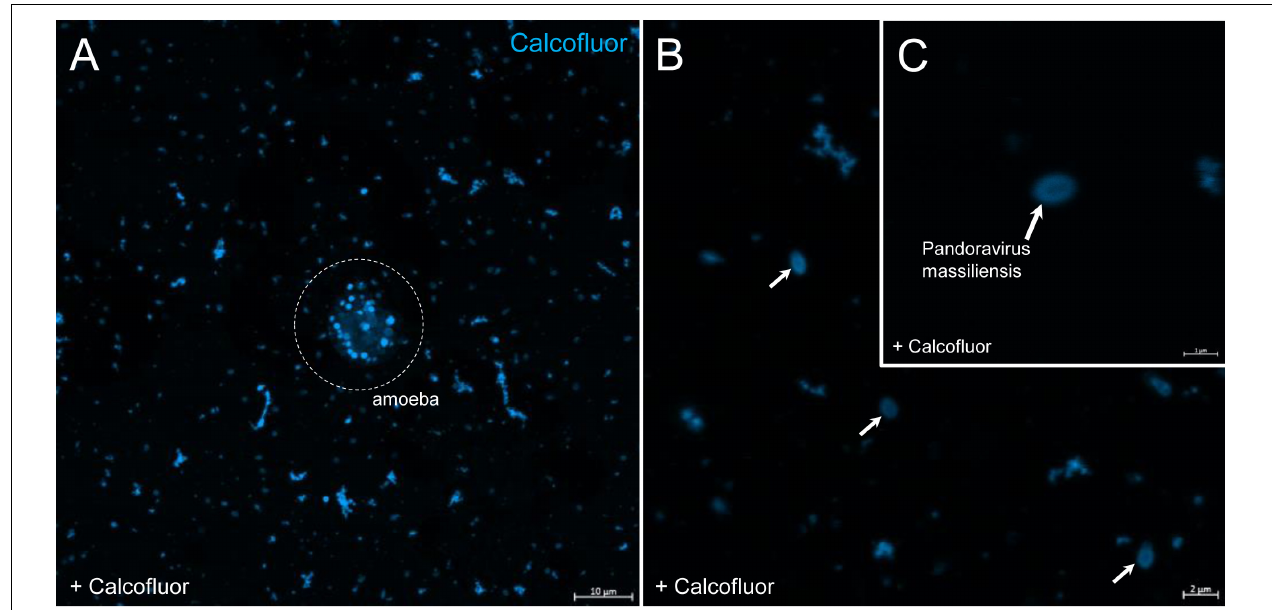
FIGURE 6 | Confocal imaging of Calcofluor staining of P. massiliensis . (A) Pandoravirus-infected ameba and single Pandoravirus particles stained with Calcofluor white. (B,C) Calcofluor-stained Pandoravirus particles showing an intense peripheral calcofluor signal and a less-stained central region.